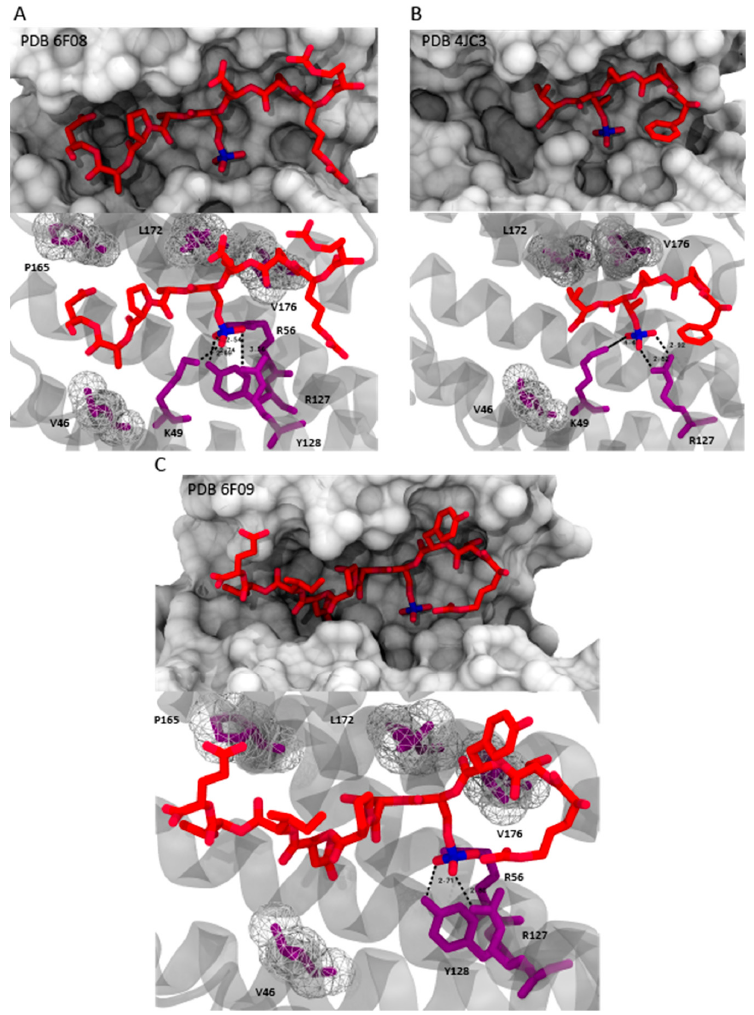
Figure 2. Common recognition motif for 14-3-3 proteins that contain a phosphorylated serine or threonine; mode II for the complex Son of sevenless homolog 1 SOS1/14-3-3 ζ (PDB ID: 6F08) [20] ( A ). Higher side: 14-3-3 ζ (white surface) and the peptide SOS1 (red sticks); lower side: Polar contacts (black dashed lines) and hydrophobic interactions (wireframe white spheres) between the residues of 14-3-3 ζ (red sticks and white-transparent cartoon) and the pSer binding site of SOS1 (violet sticks). Mode III for the complex ER α /14-3-3 σ (PDB ID: 4JC3) [21] ( B ). Higher side: 14-3-3 σ (white surface) and the peptide ER α (red sticks); lower side: Polar contacts (black dashed lines) and hydrophobic interactions (wireframe white spheres) between the residues of 14-3-3 σ (red sticks and white-transparent cartoon) and the pSer binding site of ER α (violet sticks). Mode I for the complex ubiquitin specific protease 8 (USP8)/14-3-3 ζ (PDB ID: 6F09) [22] ( C ). Higher side: 14-3-3 ζ (white surface) and the peptide USP8 (red sticks); lower side: Polar contacts (black dashed lines) and hydrophobic interactions (wireframe white spheres) between the residues of 14-3-3 ζ (red sticks and white-transparent cartoon) and the pSer binding site of USP8 (violet sticks).